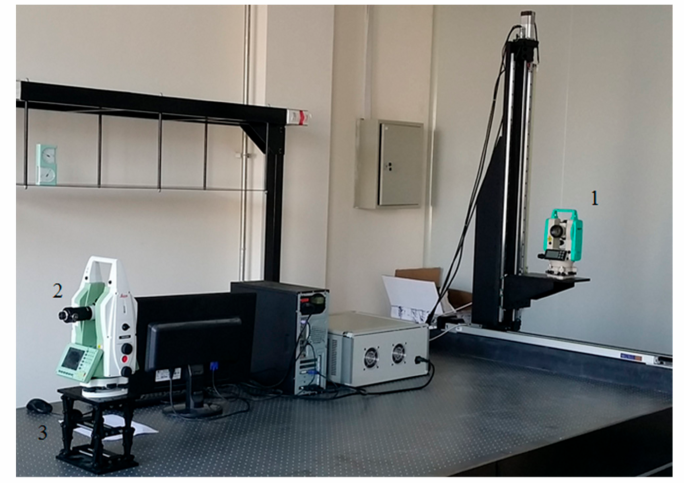
Figure 13. Alignment error testing experiment for four-axes calibration